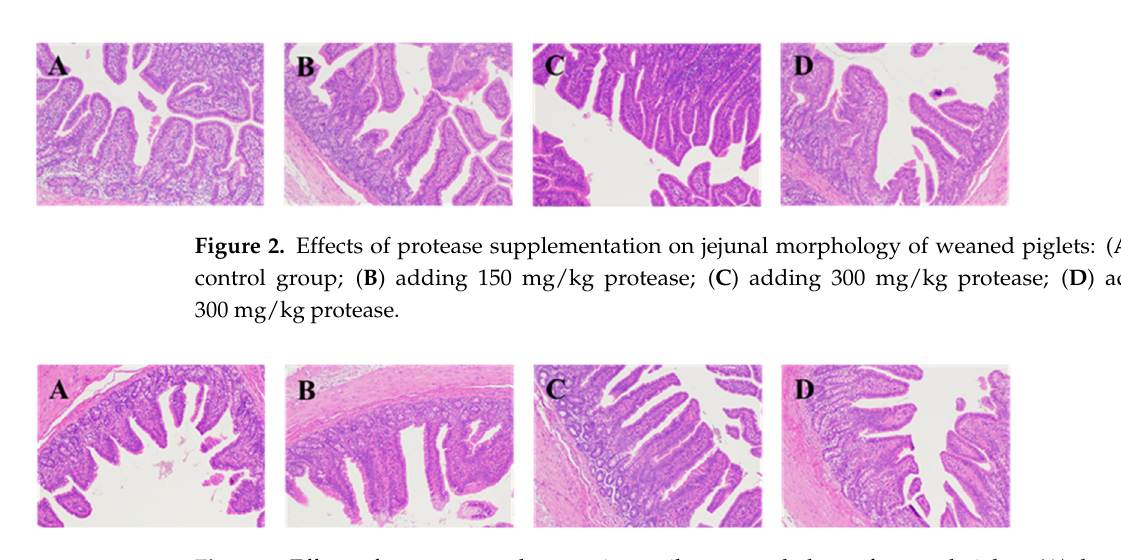
Figure 1. Effects of protease supplementation on duodenal morphology of weaned piglets: ( A ) the control group; ( B ) adding 150 mg/kg protease; ( C ) adding 300 mg/kg protease; ( D ) adding 300 mg/kg protease.